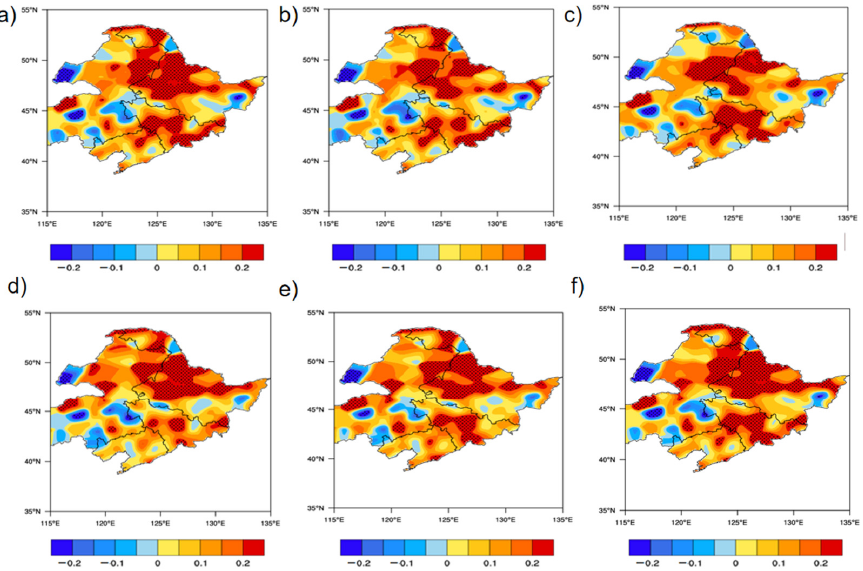
Figure 11. Spatial distribution of the correlation coefficients between NECVHR and AMO during 1961–2019 (shaded). ( a ) May; ( b ) June; ( c ) July; ( d ) August; ( e ) September; ( f ) average for May–September. Dotted areas indicate the 90% confidence level.